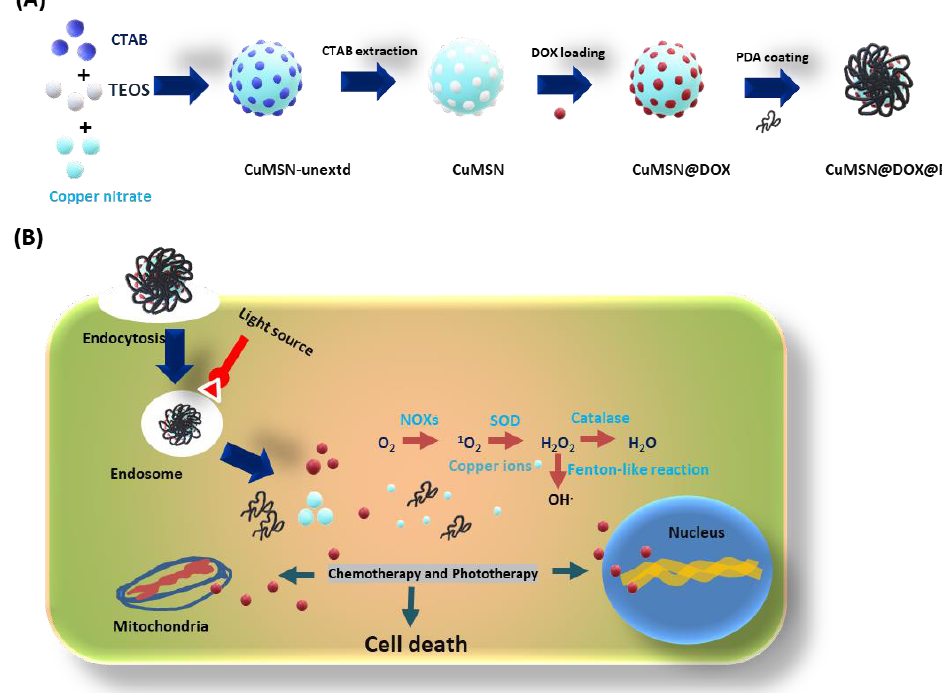
Figure 1. ( A ) Schematic explanation of CuMSN, DOX loading, and PDA coating onto the surface and ( B ) a graphical description of chemotherapy and photothermal therapy killing the A549 can- cer cells.